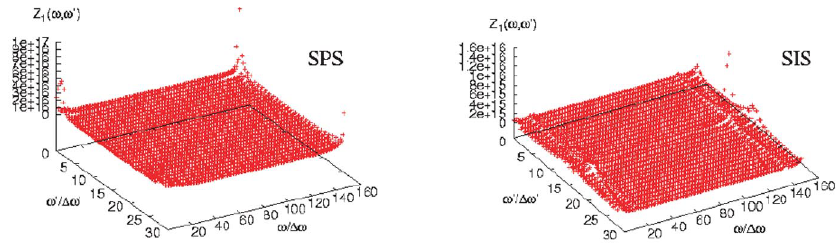
(cid:4) !; ! 0 (cid:5) obtained for a uniform bunch profile in the SPS (left) and in the GSI-SIS18 FIG. 75. (Color) Two-dimensional impedance ^ Z 1 including the effect of a detuned electron cooler (right) [91,109].